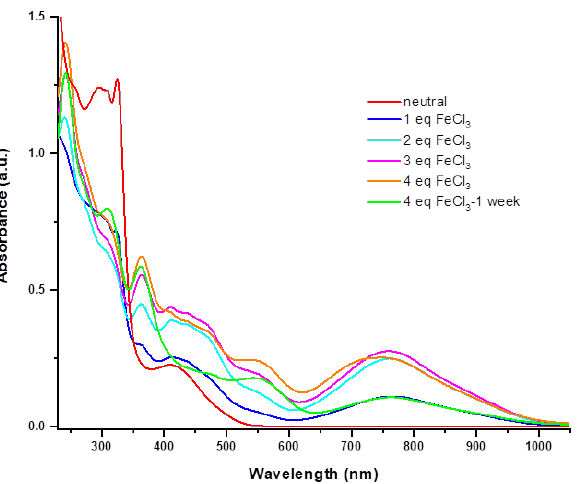
Figure 3. UV-Vis absorption spectra of ( rac )- 1 during chemical oxidation by successive addition of FeCl 3 in DCM at room temperature.